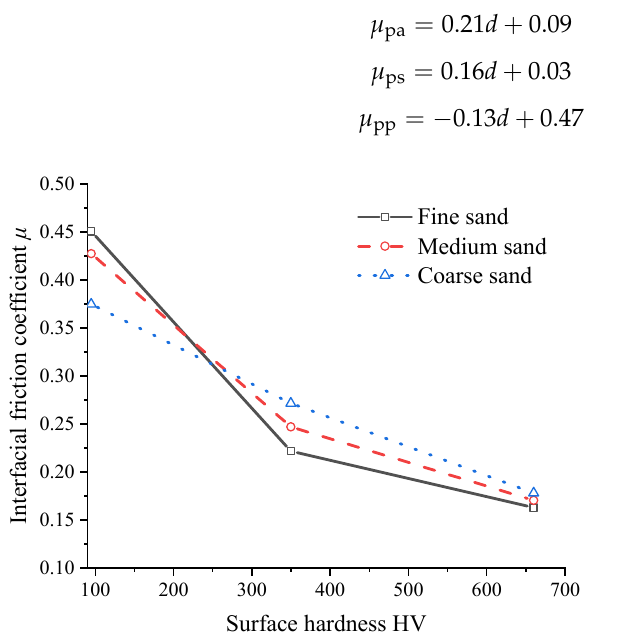
Figure 7. Relationship between surface hardness and peak interfacial friction coefficient.